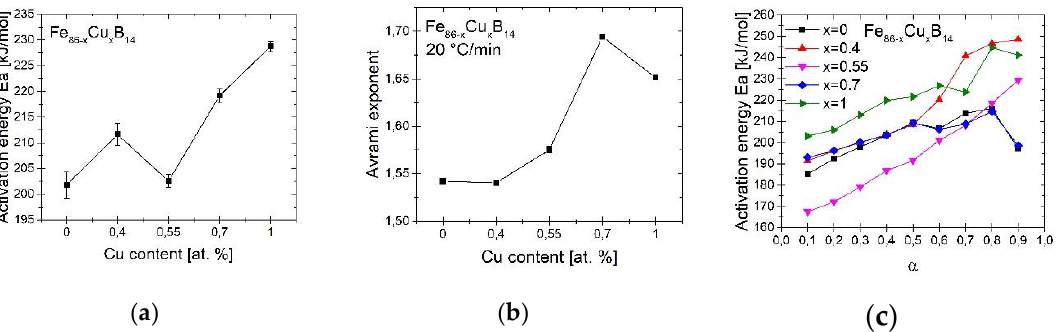
Figure 3. Influence of Cu content on: average activation energy Ea ( a ), fraction dependent activation energy of α -Fe phase crystallization ( b ) and Avrami exponent ( c ).